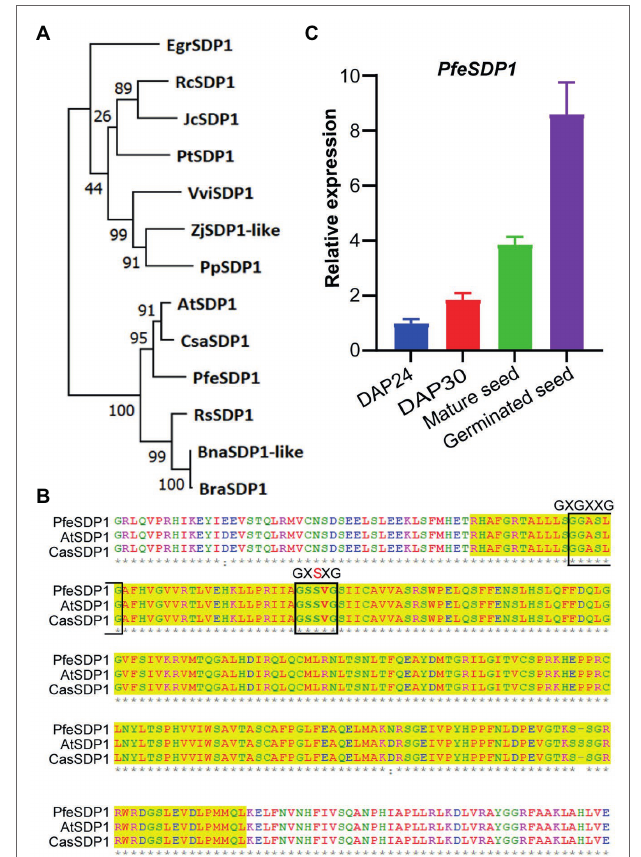
FIGURE 1 | Homology of Physaria fendleri SDP1 and expression in seed tissue. (A) Phylogenetic analysis of P. fendleri and other SDP1 proteins. The phylogenetic tree was constructed using MEGA11. Numbers at the tree branches indicate percent bootstrap support of 1,000 iterations. Species abbreviations and accession numbers of each protein given in Supplementary Table S2 . (B) An amino acid alignment of patatin domain of P. fendleri with Arabidopsis and Camelina SDP1. Lipase motifs GXGXXG and GXSXG are highlighted with a black box. Protein aliment was performed using ClustalW. (C) Relative expression of the PfeSDP1 gene during seed development and germinated seeds, the expression quantified by qRT-PCR and normalized to the reference 18S gene. DAP24; DPA30; indicates 24 and 30 days after pollination, respectively. Expression values are the average